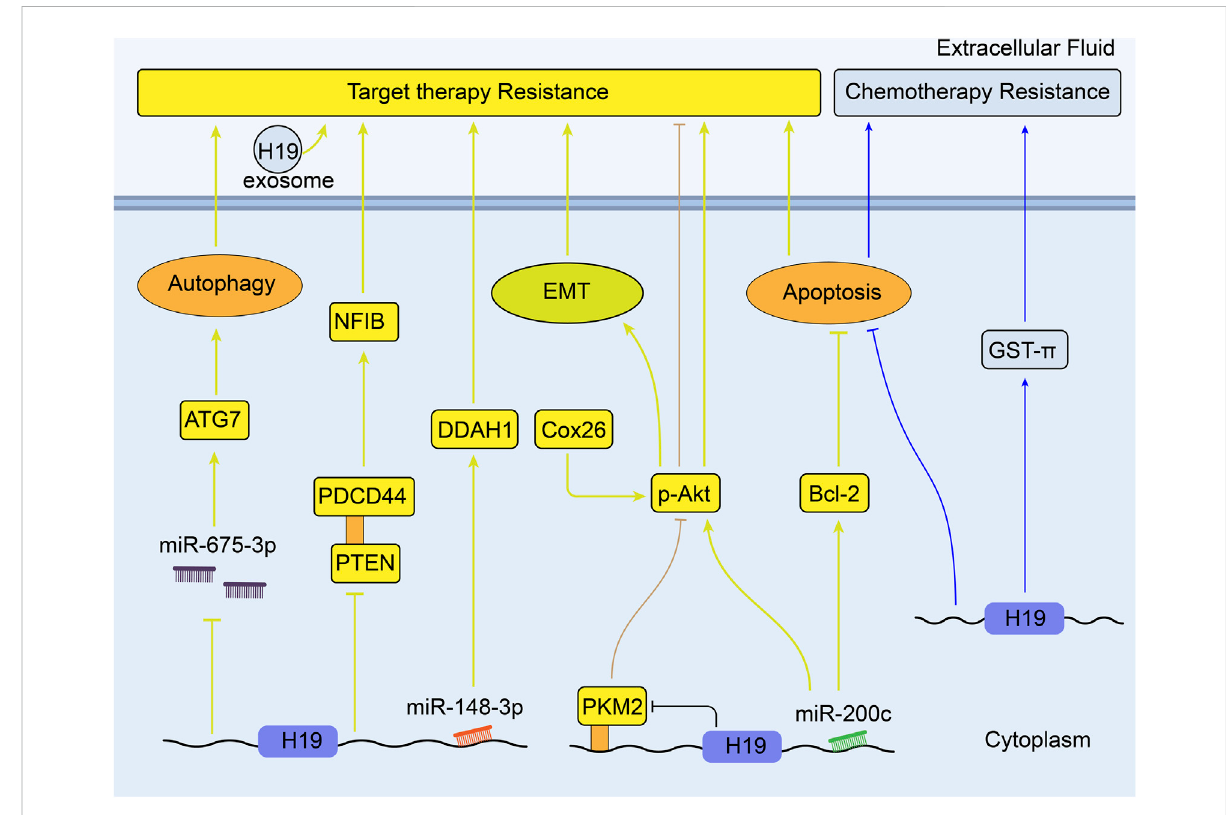
FIGURE 4 Overview of the role of H19 in modulating lung cancer therapy